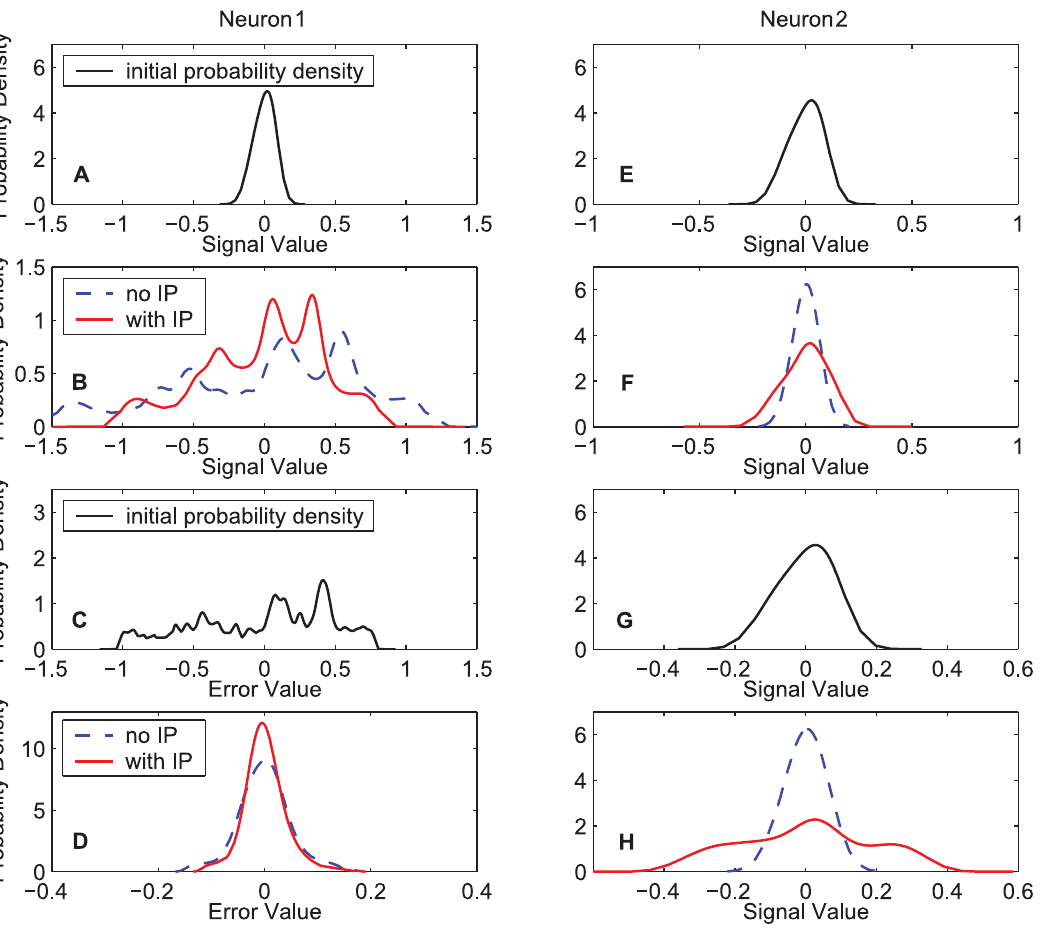
Figure 13. Input, output and error distributions for neurons of the RNN. The training data set ‘‘MG’’ is used. Neuron 1 (output neuron): (A) Initial input distribution. (B) Input distributions after 1000-epoch training for the two algorithms. (C) Initial error distribution. (D) Error distributions after 1000-epoch training for the two algorithms. Neuron 2: (E) Initial input distribution. (F) Input distributions after 1000-epoch training for the two algorithms. (G) Initial output distribution. (H) Output distributions after 1000-epoch training for the two algorithms. In (B), (D), (F), and (H), the dash lines denote the distributions obtained by the MEE algorithm, and the solid lines denote the distributions obtained by the synergistic algorithm.